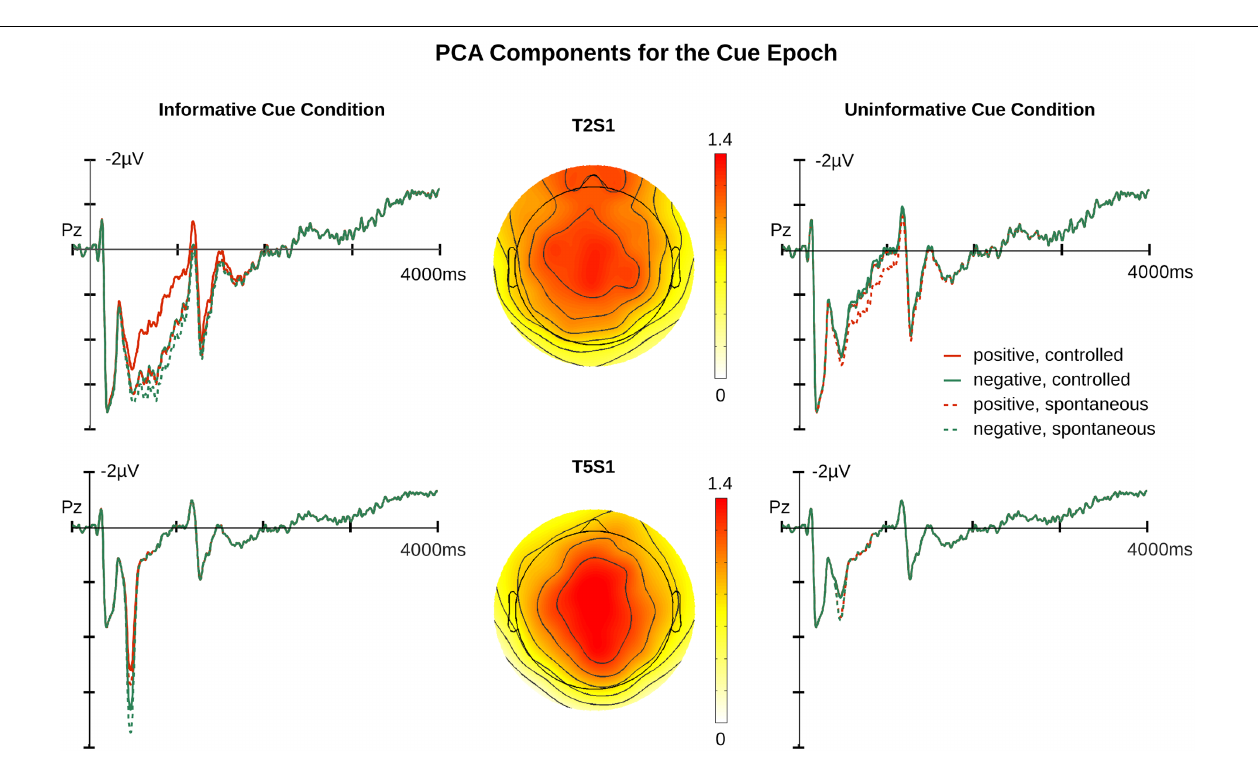
FIGURE 3 | Relevant principal component analysis (PCA) components for cue epochs. Illustrated in the upper row are T2S1 traces and topography. Illustrated in the lower row are T5S1 traces and topography. The waveforms are the projection traces for each component at Pz. T2S1cue component peaked at 754 ms after cue onset. T5S1cue component peaked at 473 ms after cue onset. Additional time course information is available in the Supplementary Materials.